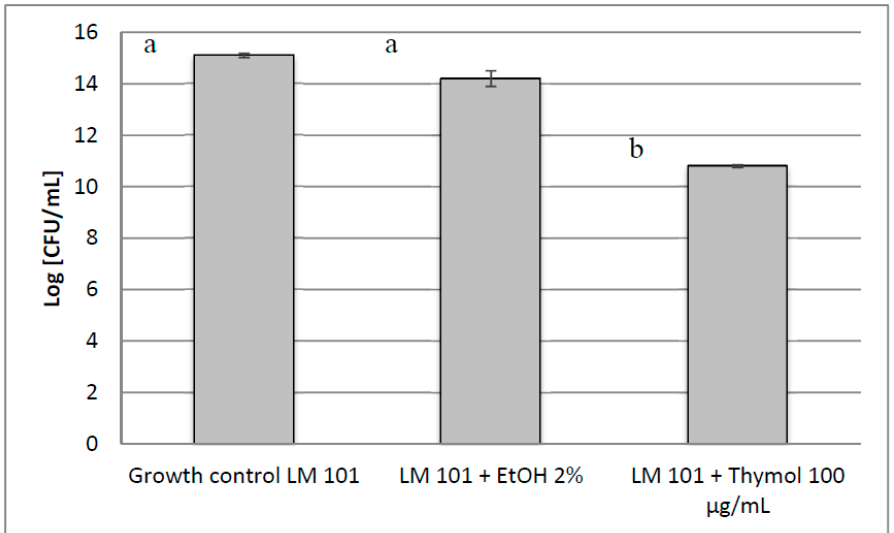
Figure 3. Inhibition of L. monocytogenes 101 (LM 101) biofilm formation on a stainless-steel surface. The averages from three independent experiments are reported with the SD values and error bars represent the SD of the data. Different letters among bars indicate statistical differences at p < 0.05.